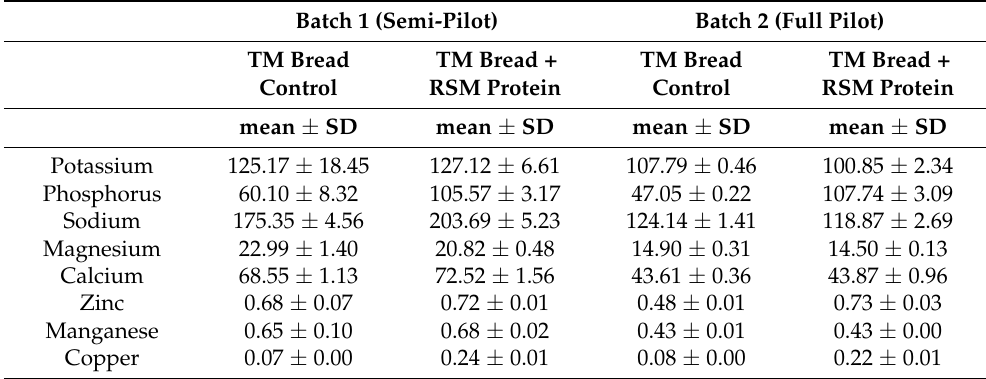
Table 10. Mineral and trace element contents of TM bread: control and RSM-protein-supplemented (5% w/w ) samples. Values are expressed as mg per 100 g of fresh